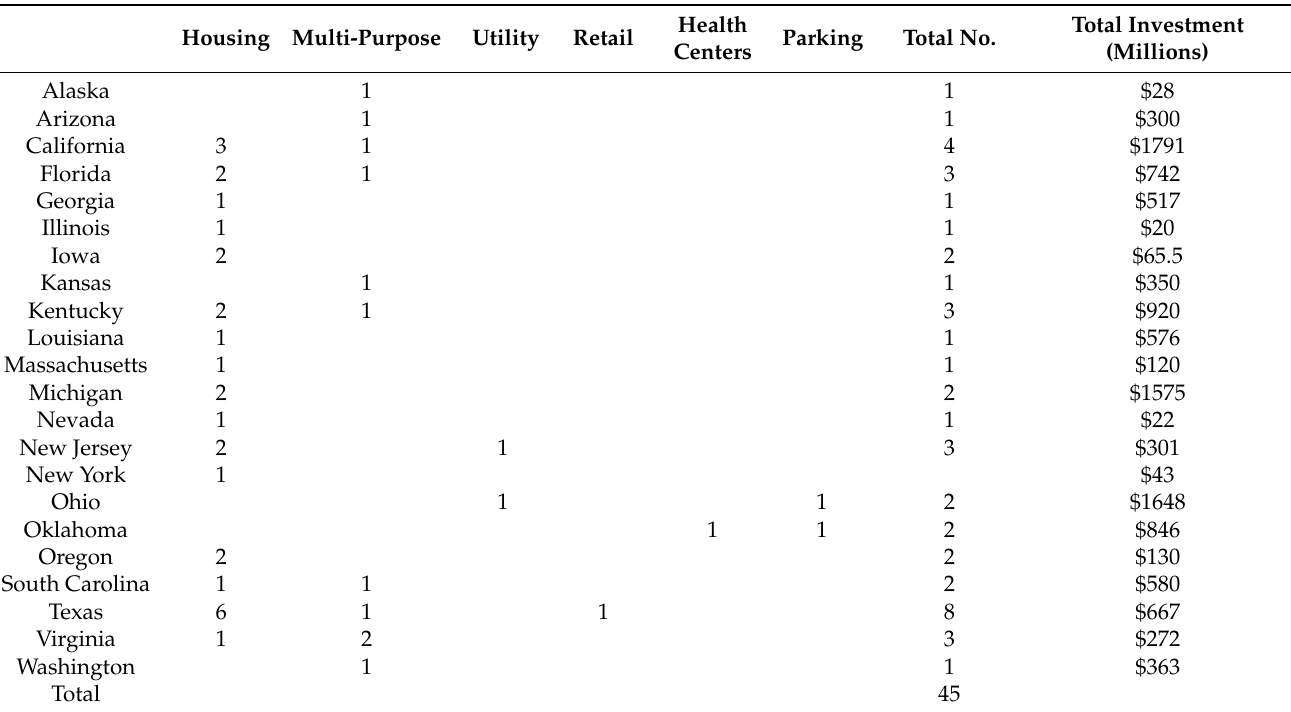
Table 3. Breakdown of the 45